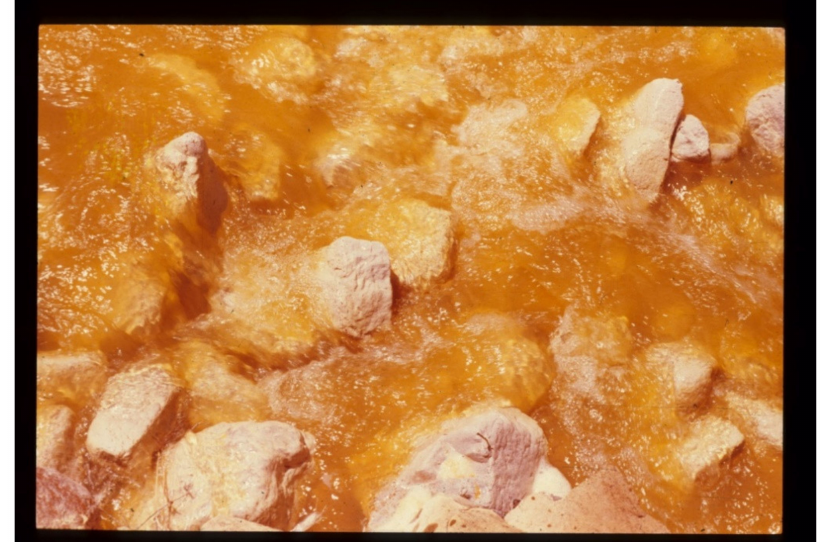
Figure 2. White aluminum-rich precipitate found below the confluence of Leviathan and Mountaineer Creeks, near Markleeville, California. Photo: D. Kirk Nordstrom, U.S. Geological Survey, June